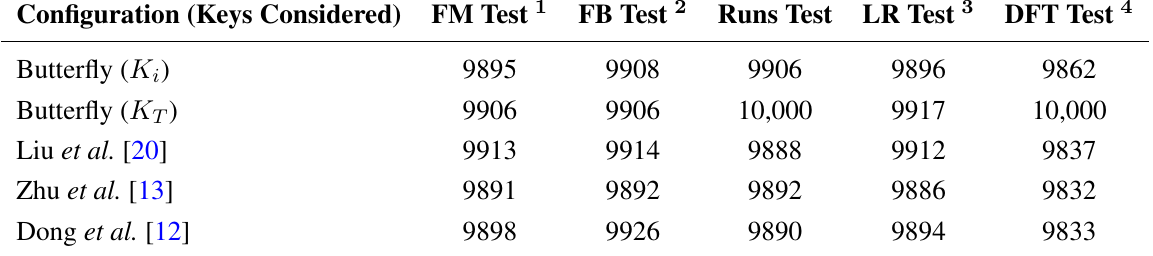
Table 3. NIST STS Assessment: Summary of results (Number of sequences out of 10,000 that passed each test).